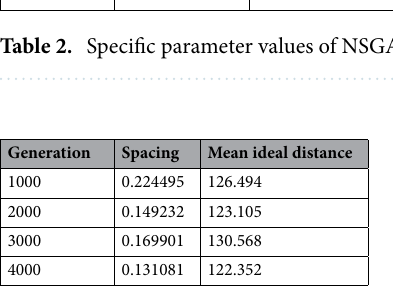
Table 3. Performance of algorithms under different